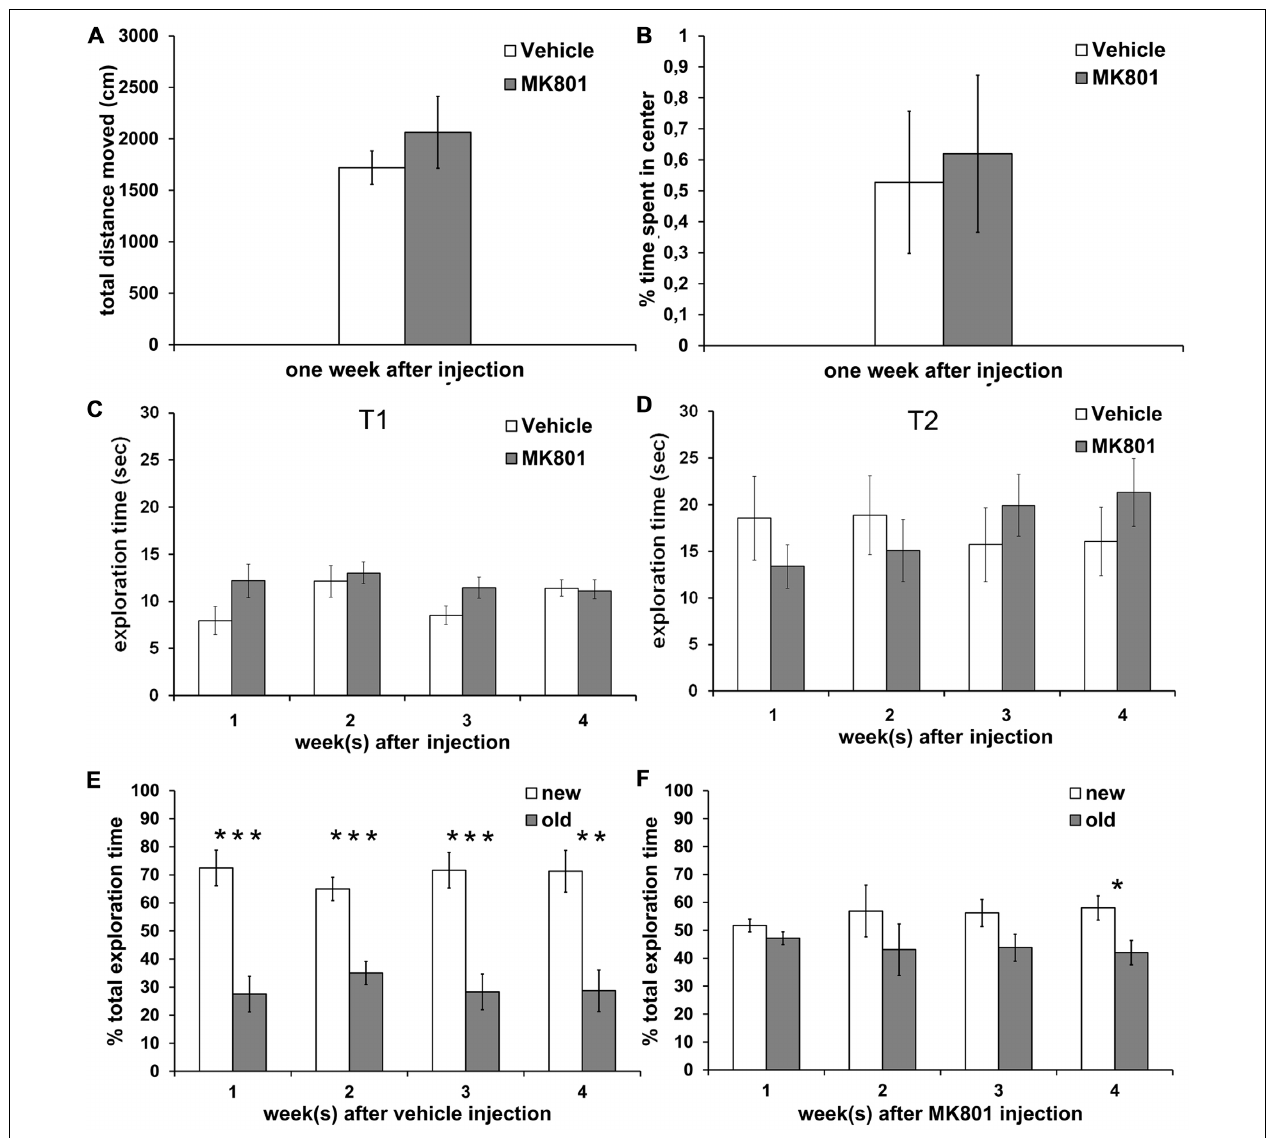
FIGURE 4 |Acute treatment with an irreversible NMDA antagonist disrupts object recognition memory for several weeks after treatment. Locomotor activity and anxiety-related behavior are not affected. (A) Locomotor activity is not different between rats treated with vehicle (white column, n = 7) or MK801 (gray column, n = 7) 1 week prior to the experiment. (B) Vehicle (white column, n = 7) and MK801-injected rats (gray column, n = 7) spend an equal % of time in the center of the open field arena one week after treatment. (C , D) Total exploration times do not differ significantly between the vehicle- (white column) and MK801-treated (gray column) rats duringT1 (first exposure to two new objects) and duringT2 (exposure 4 h later to one familiar object and one novel object). (E) Control rats remember the familiar object after an interval of 4 h, as indicated by